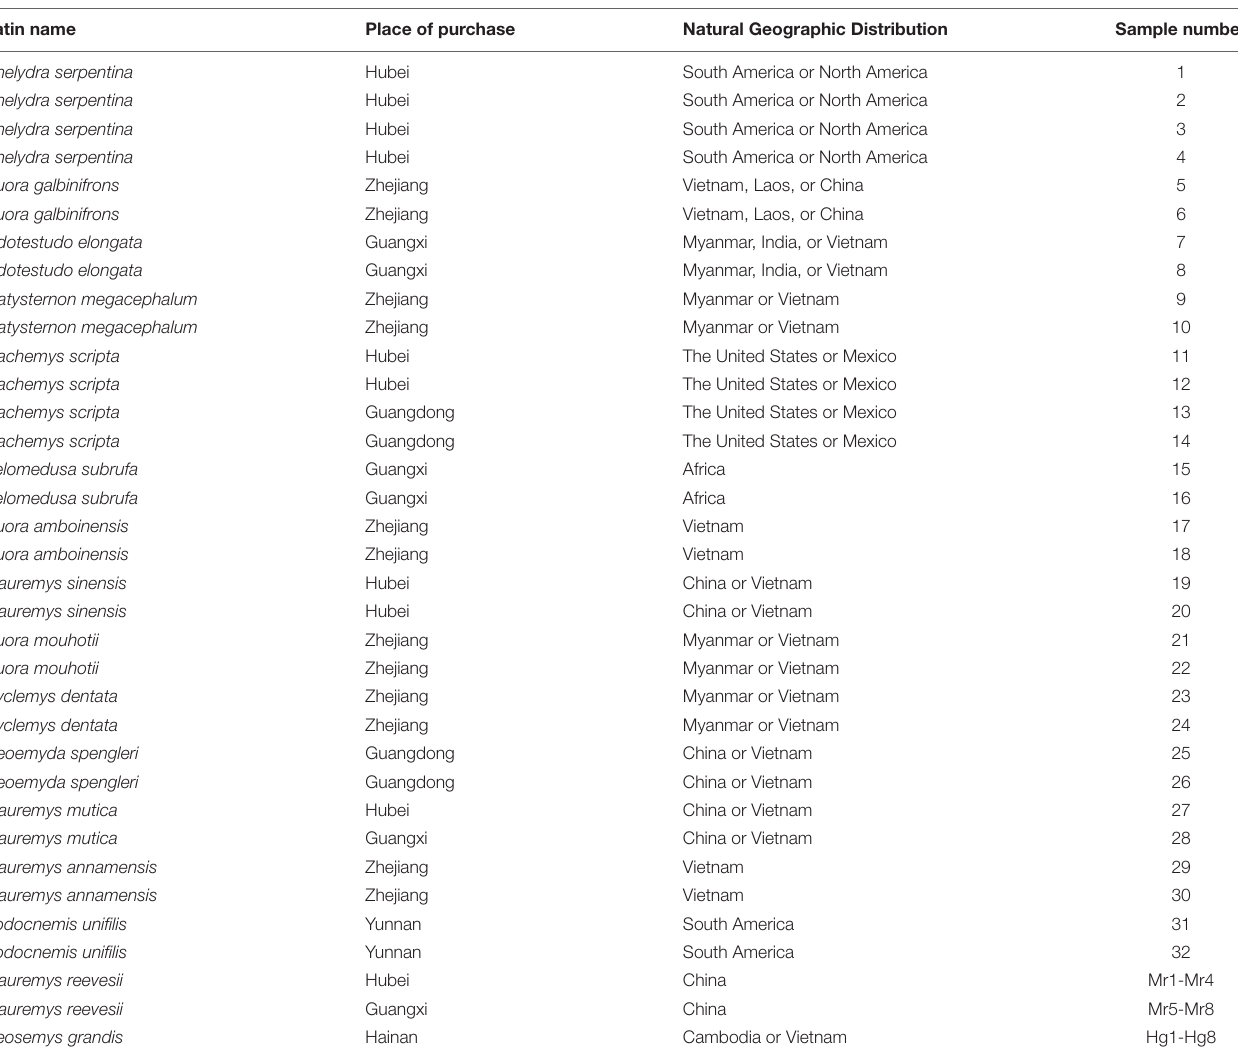
TABLE 1 | Information on all samples used in this